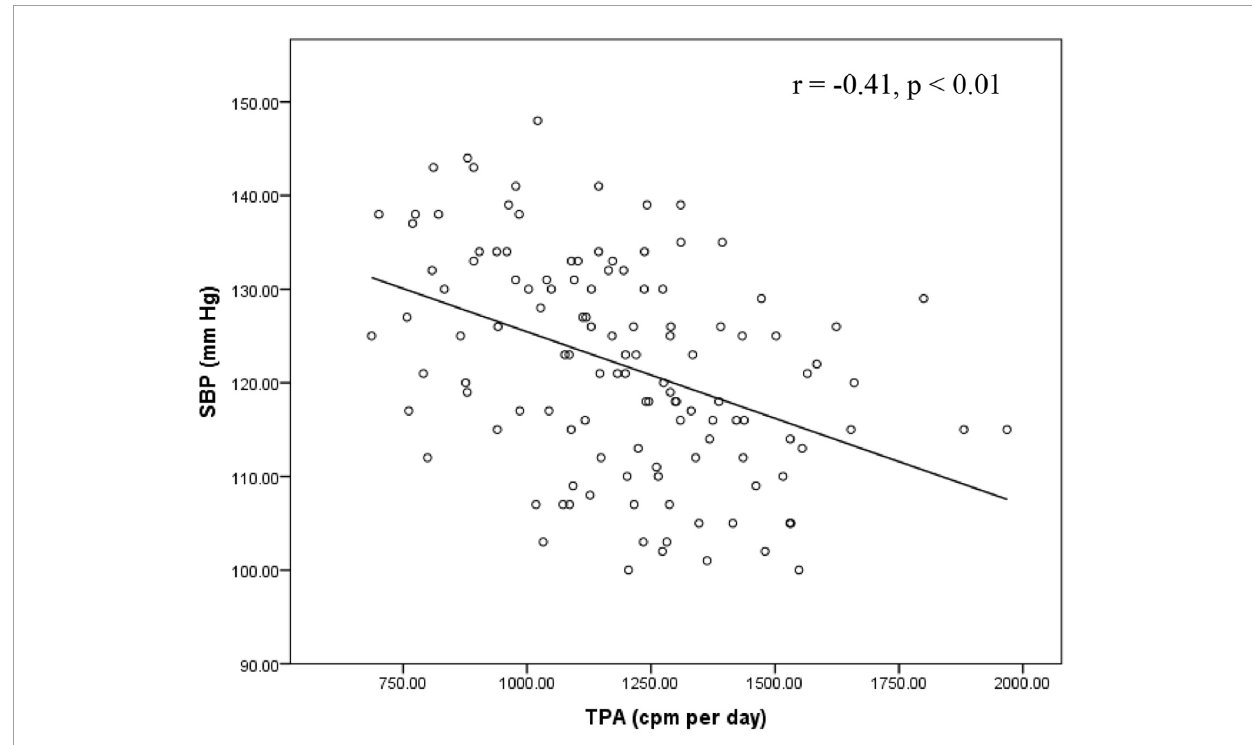
FIGURE4 Relationship between SBP and TPA in the total sample. cpm, count per minute; SBP, systolic blood pressure; TPA, total physical